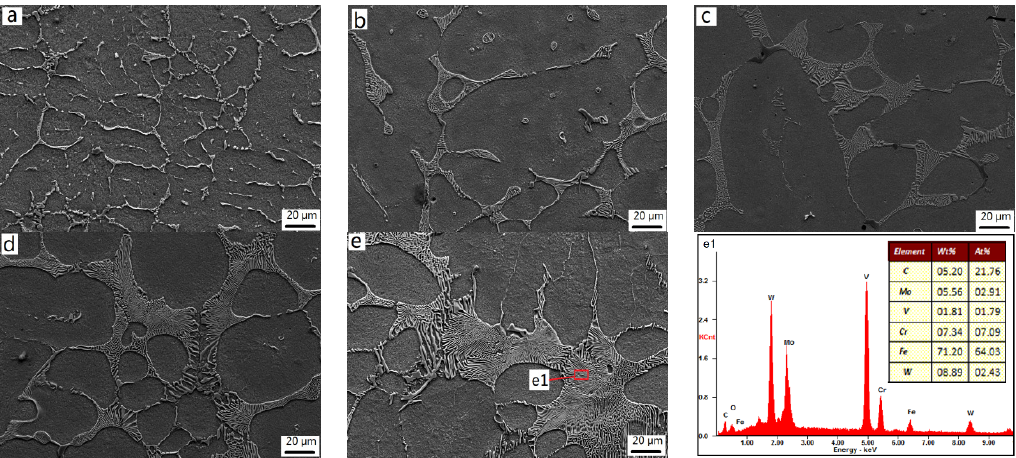
Figure 8. Distribution of carbides in the different samples from the sand mold billet ( a – e ×500 for the billet from edge to center, e1 for the composition of the carbide determined by scanning electron microscopy (SEM)).